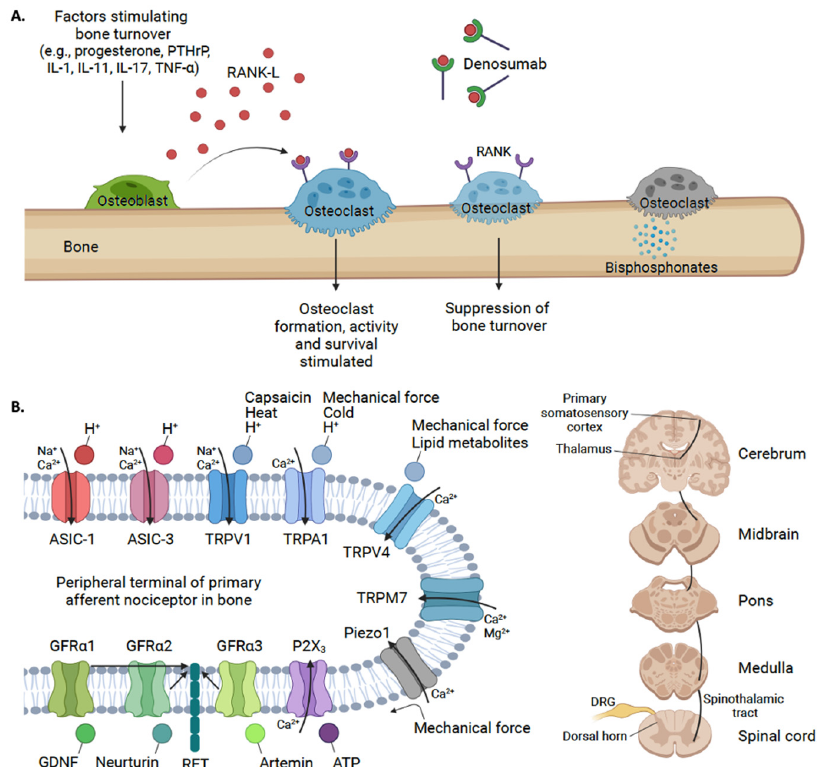
Figure 4. ( A ) RANK-L binds to RANK on osteoclasts resulting in differentiation and maturation of osteoclasts and subsequent bone resorption [97]. Denosumab binds to RANK-L and inhibits its action, and prevents osteoclast recruitment and maturation, resulting in slowed bone resorption [35]. Bisphosphonates prevent bone resorption by binding to hydroxyapatite and inhibiting osteoclast function [98]. ( B ) Nociceptive signaling molecules on primary sensory neurons innervating skeletal tissue can include the transient receptor potential (TRP) family channels, acid-sensing ion channels (ASICs), mechanosensitive ion channels (Piezo1), purinergic receptors (P2X 3 ), and Glial cell line- derived neurotrophic factor (GDNF)/ GDNF Family Receptor Alpha (GFR α ) receptors [72]. Bone pain may involve the activation and sensitization of neurons via Glial cell line-derived neurotrophic factor (GDNF)/GFR α 1, neurturin/GFR α 2, and artemin/GFR α 3 signaling pathways [75,95]. The percephin/GFR α 4 complex is not included. When peripheral afferent neurons in bone tissue, with their cell bodies located in the dorsal root ganglion (DRG), are activated, nociceptive signals are carried via the spinothalamic and ascending pain pathways to convey pain signals to various regions in the brain [99,100]. Note that the activation of GFR α receptors may yield a potential increase in synaptic channel or receptor expression and/or sensitization (Created with BioRender.com, accessed on 5 August